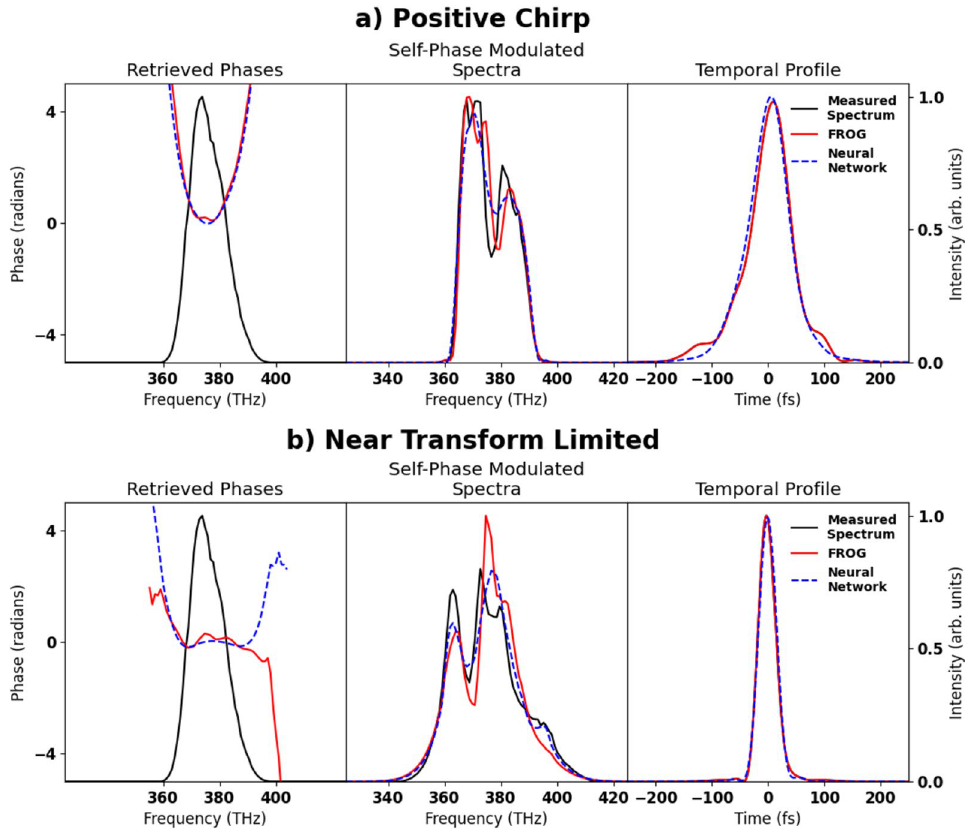
Figure 6. Experimental phase reconstruction phases measured from experimental data. Spectra measured after propagating through 8 mm of fused silica at Brewster’s angle. Spectra and temporal profiles are normalized to the area under the curve. (a) FROG reconstruction of a positively chirped laser pulse in comparison to the reconstructed results from the neural network. Self-Phase modulated spectra and temporal profile are normalized to area under the curve for ease of comparison. (b) FROG reconstruction of a near transform- limited pulse in comparison to the reconstructed results from the neural